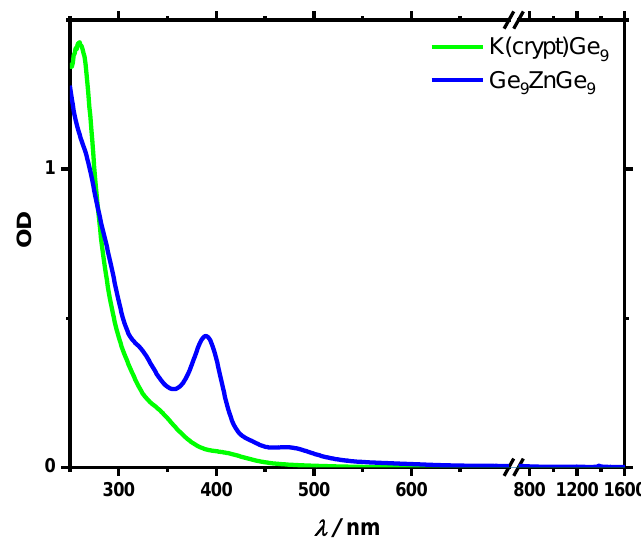
Figure 2. Absorption spectra for K(crypt)Ge 9 and Ge 9 ZnGe 9 between 250 and 1600 nm in THF solution with a concentration of about 1 mmol/L. Spectra of KGe 9 and LiGe 9 are very similar to K(crypt)Ge 9 and can be found in the SI Figure S1.